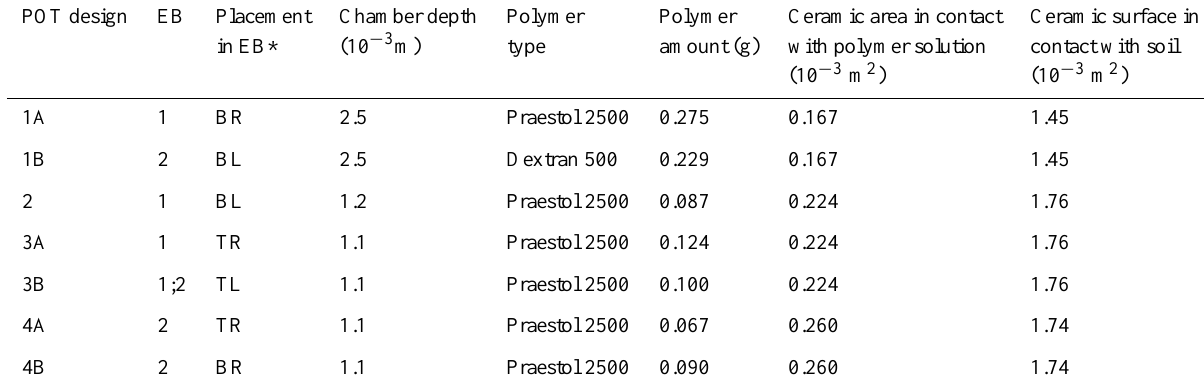
TR 1.1 Praestol 2500 0.124 3B 1;2 Praestol 2500 0.100 0.224